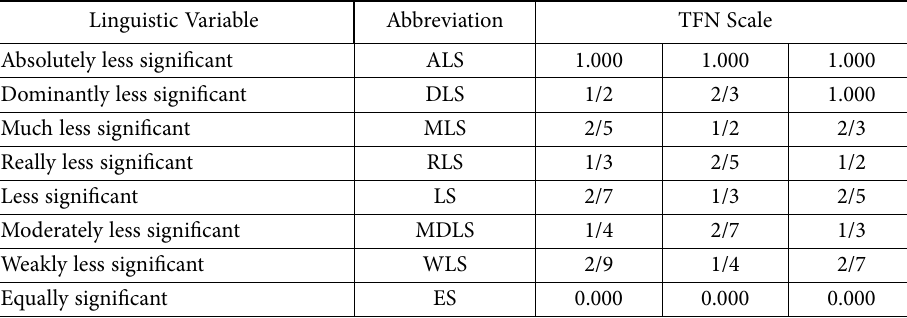
Table 3. The linguistic scale for the IMF SWARA technique and TFNs (Vrtagić et al., 2021) Linguistic